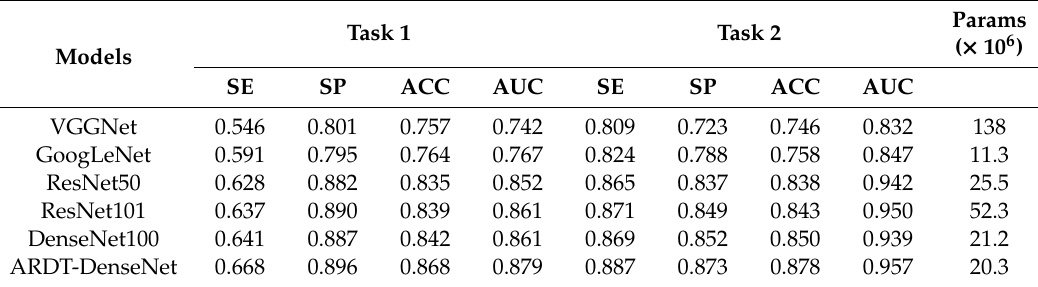
Table 5. Comparison of baseline models on ISIC